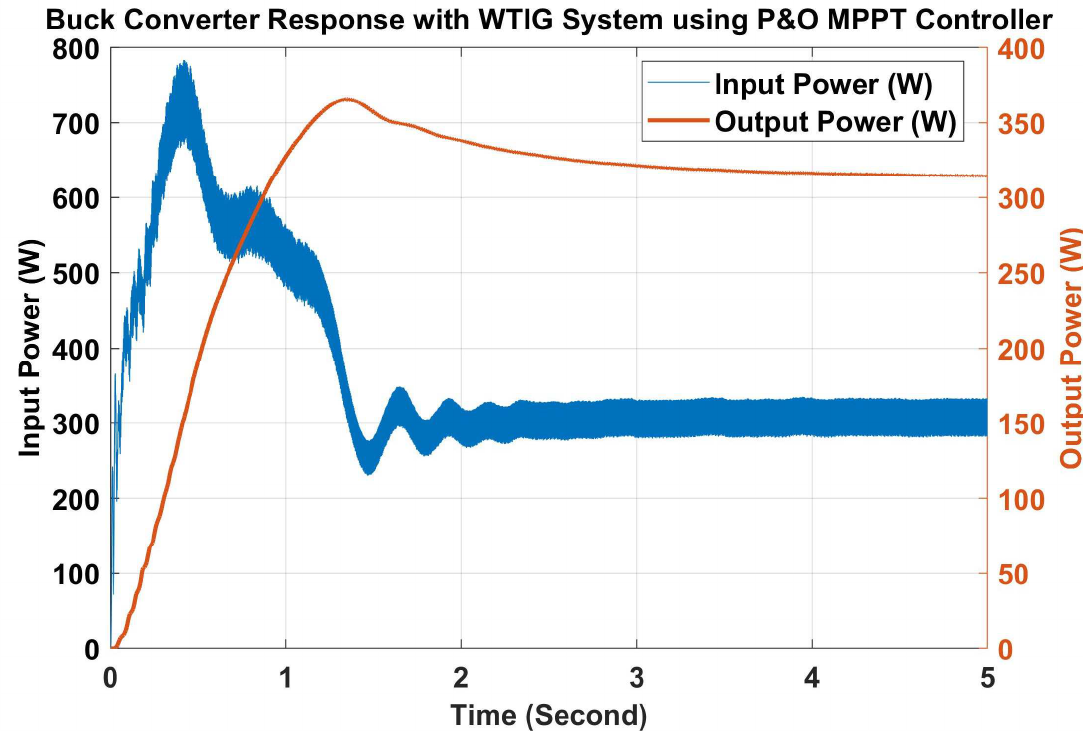
Figure 7. Input and Output Power of Buck Converter with WTIG System and P-&-O MPPT.